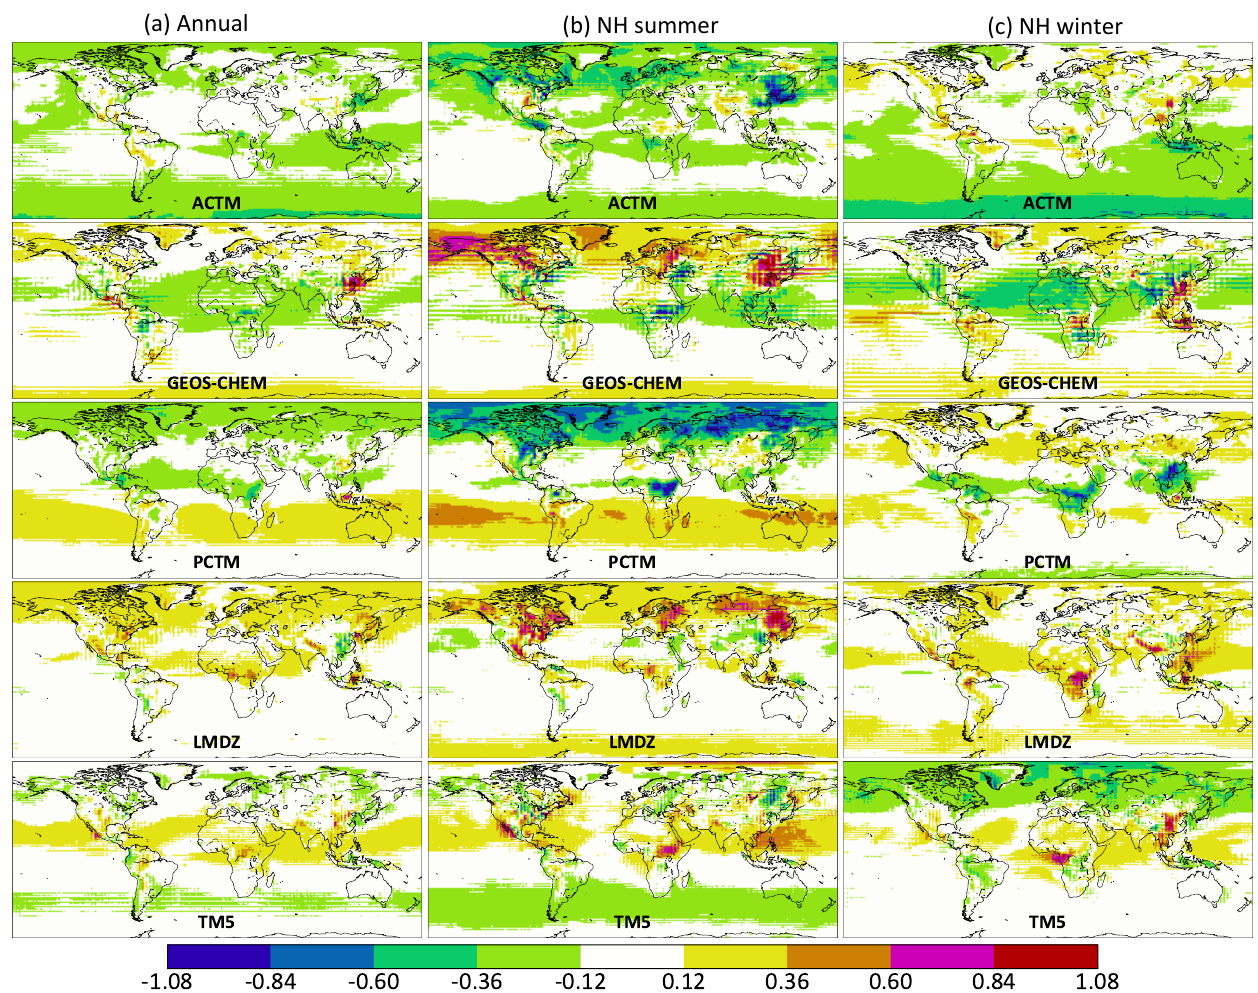
Figure B2. Same as Fig. B1 except averaged over the total column. The dynamic range here is half that of Fig. B1, since transport differences in the total column signal are smaller than in the PBL